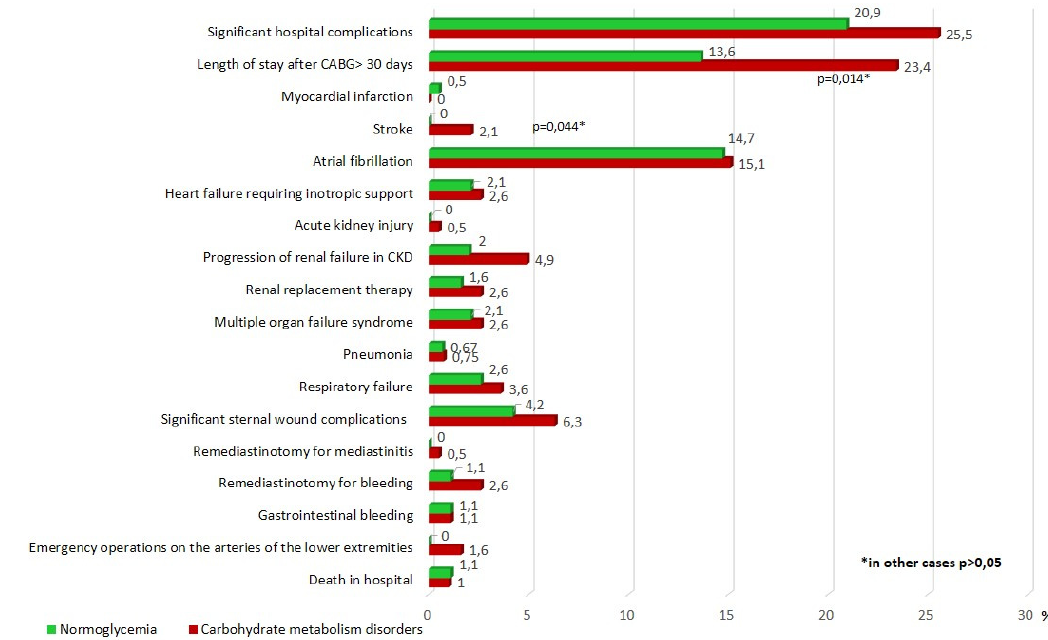
Figure 2. Postoperative hospital complications after CABG. Notes: CABG—coronary artery bypass grafting, CKD—chronic kidney disease, p —significance of differences between groups, *— p < 0.05.